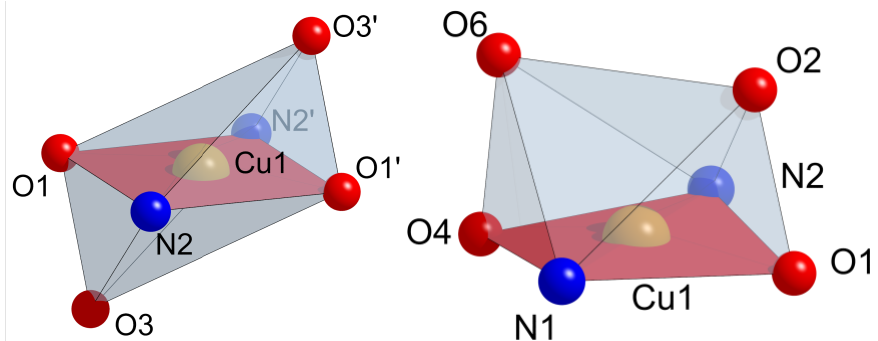
Figure 2. Environment of the Cu atom in the two isomers of [Cu(L) 2 (NO 3 ) 2 ] with atom numbering. ( left ): CuL 1 , L 1 = 2 ‐ bromo ‐ 5 ‐ methylpyridine in P 2 1 /c; ( right ): CuL 2 , L 2 = 2 ‐ bromo ‐ 4 ‐ methylpyridine in P 1 (cid:3364) .